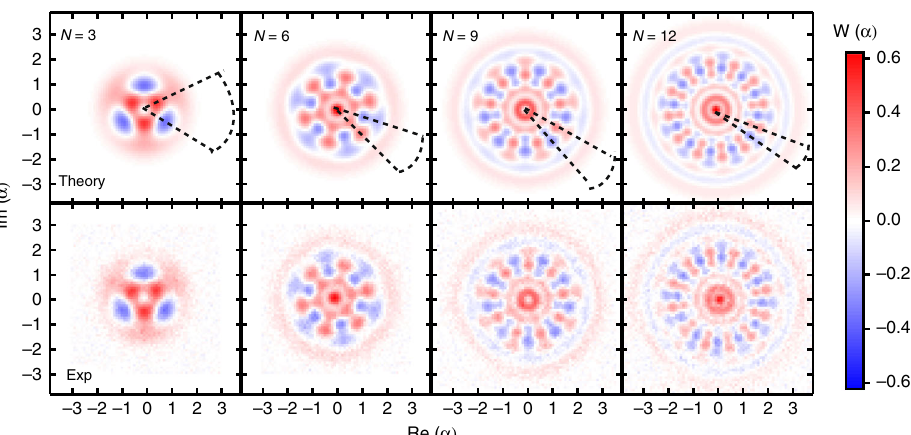
ffiffiffi p 2 with state